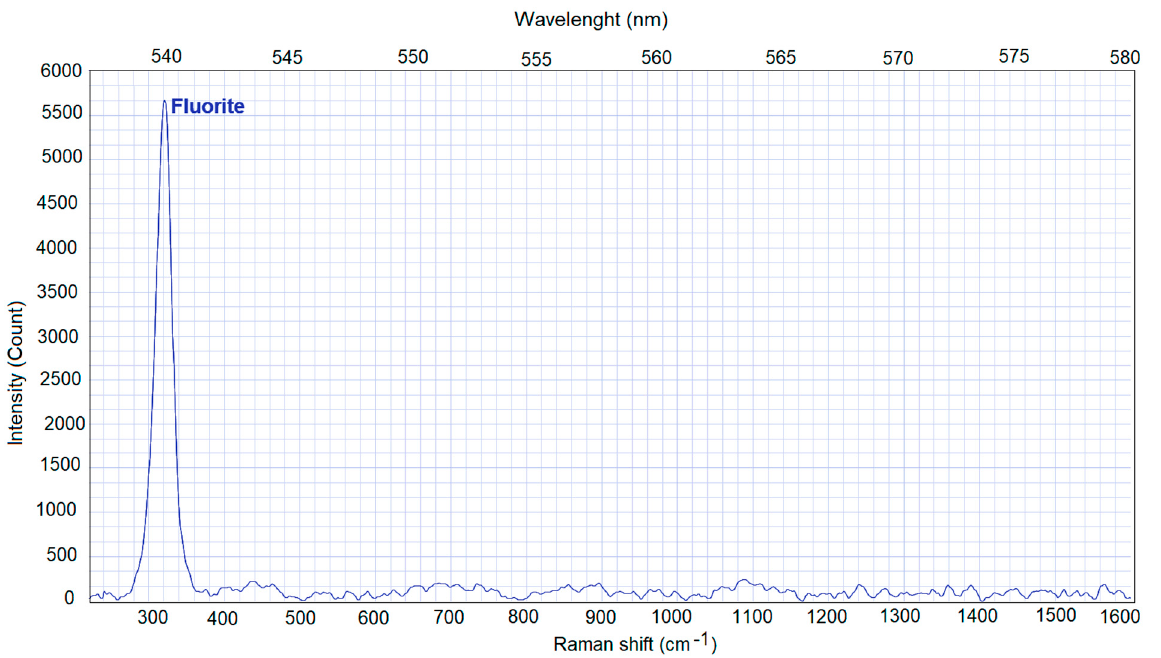
Figure 4. Results obtained from the analysis of the NF sample by Raman Spectroscopy.